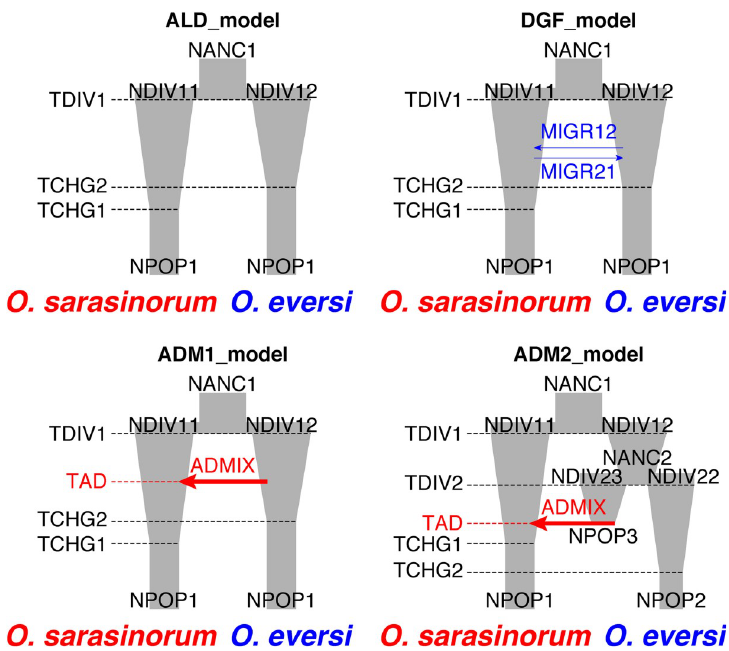
Fig 2. Schematic illustration of two-population demographic models. Note that growth was modeled as exponential and not linear as depicted